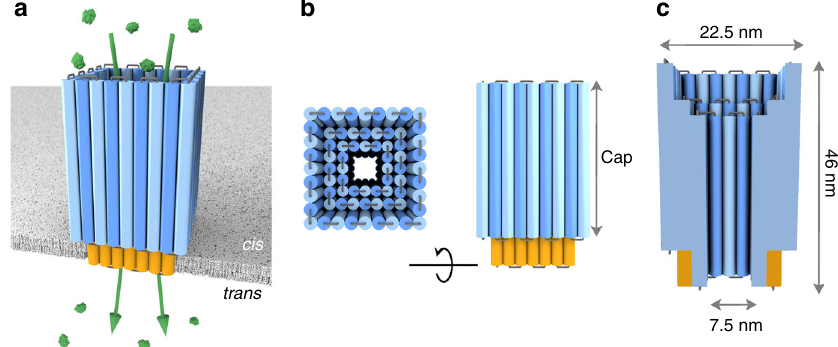
Fig. 1 The rationally designed large membrane-spanning DNA nanopore NP. a The pore is composed of squarely arranged DNA duplexes, which are illustrated as blue and orange cylinders. The latter carry cholesterol lipid anchors for membrane insertion. Protein trypsin (green) can pass via the pore from the cis to the trans side of the membrane. b Top-down and side views of the nanopore. c Cross-sectional side view illustrating the geometry of the